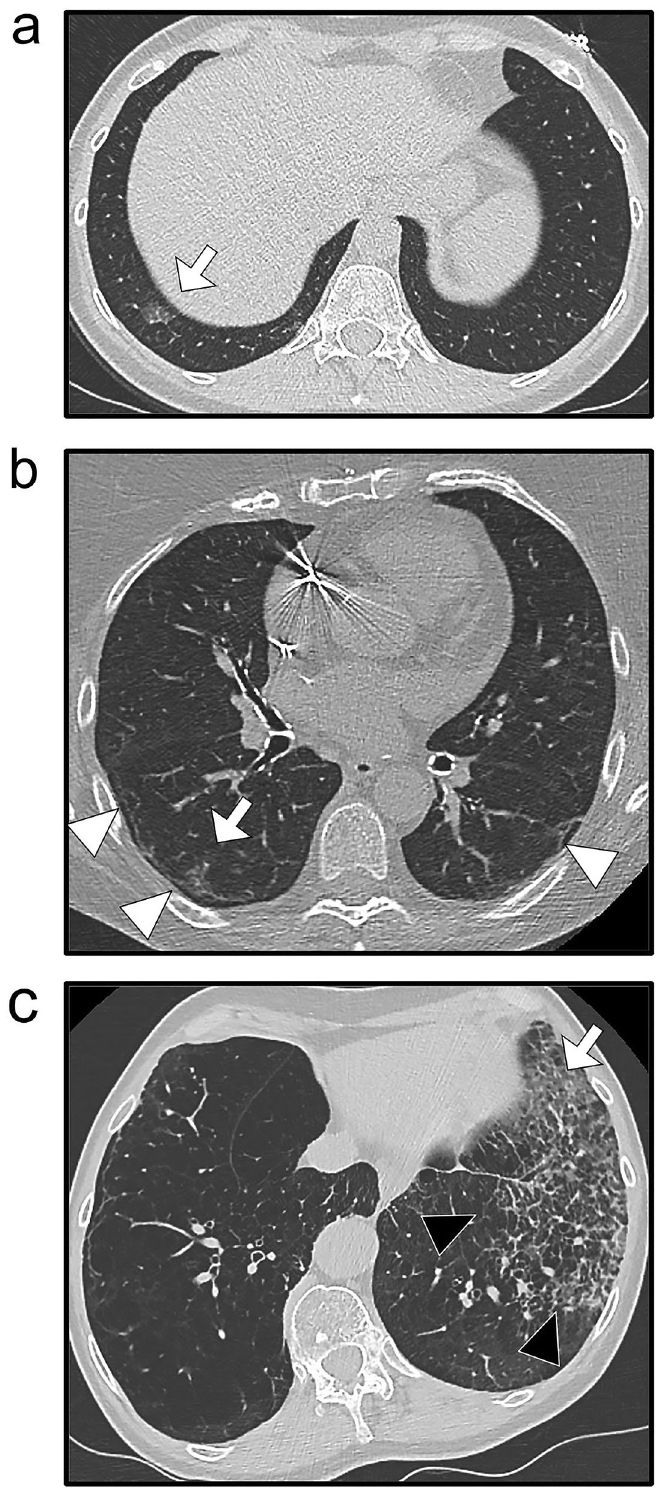
Figure 5. Added value of the final clinical-radiological model for patients with indeterminate/compatible radiological conclusions. ( a ) A 50-year-old woman presented at the emergency with chest pain, fever, and cough for less than one week. Chest CT showed a basal- predominant peripheral ground-glass opacity (GGO—white arrow) in the lower right lobe. The probability for RT-PCR + was 68.9%. ( b ) A 71-year-old woman presented at the emergency with cough, dyspnoea, fever and asthenia for 1–2 weeks. Chest CT showed bilateral peripheral fibrotic bands (white arrowheads) with a peripheral right GGO (white arrow). The probability for RT-PCR + was 65%. ( c ) A 61-year-old woman with a medical history of active smoking, emphysema and chronic obstructive pulmonary disease presented at the emergency with a cough, dyspnoea, fever and asthenia. Chest CT showed peripheral predominant intralobular reticulations in the lower left lobe (black arrowheads) with a single area of non-rounded GGO (white arrow). The probability for RT-PCR + was 57.9%. In the three cases, the RT-PCR was indeed